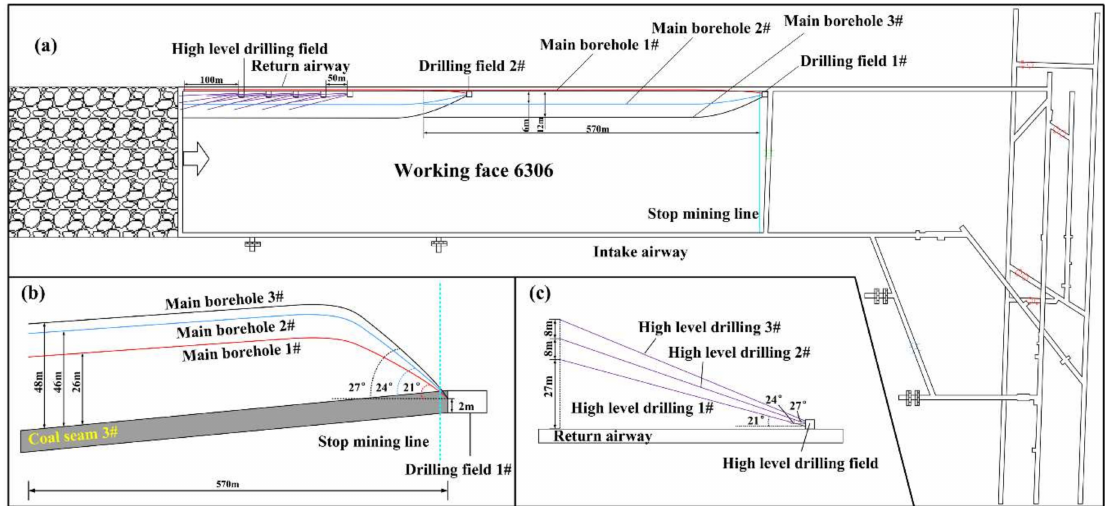
Figure 12. Layout of methane drainage system for No. 6306 working face. ( a ) Projection for drilling the long horizontal borehole in roof and the roof high level boreholes; ( b ) Lateral view of the long horizontal borehole through roof; ( c ) Lateral view of the roof high level boreholes.